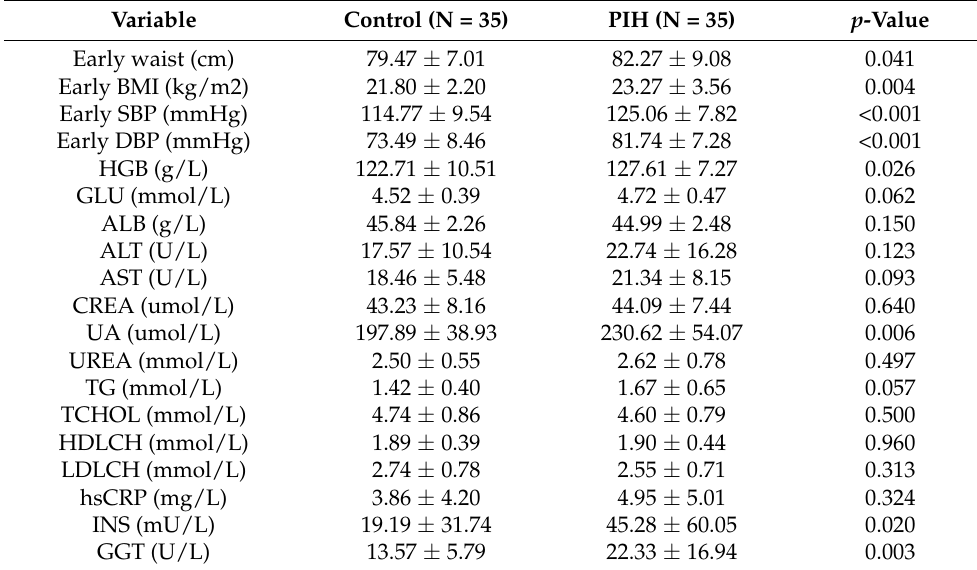
Table 2. Clinical characteristics of